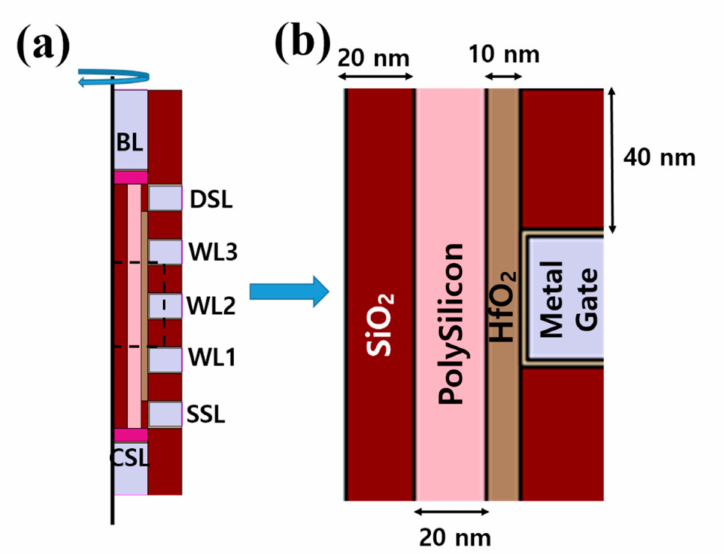
Figure 4. Details of the simulated device. ( a ) Schematic of the three stacked memory cells, namely, word lines, WL1 to WL3, and select transistors, namely, SSL and DSL transistors, bit line (BL), and CSL. ( b ) Expanded view of the simulated structure with dimensions of the constituent